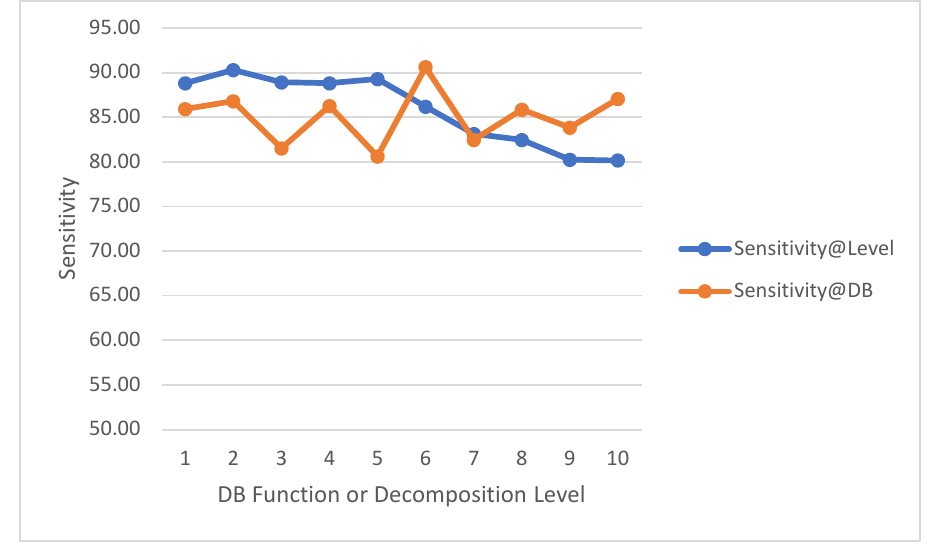
Figure 9. Sensitivity due to DWBF and DL.